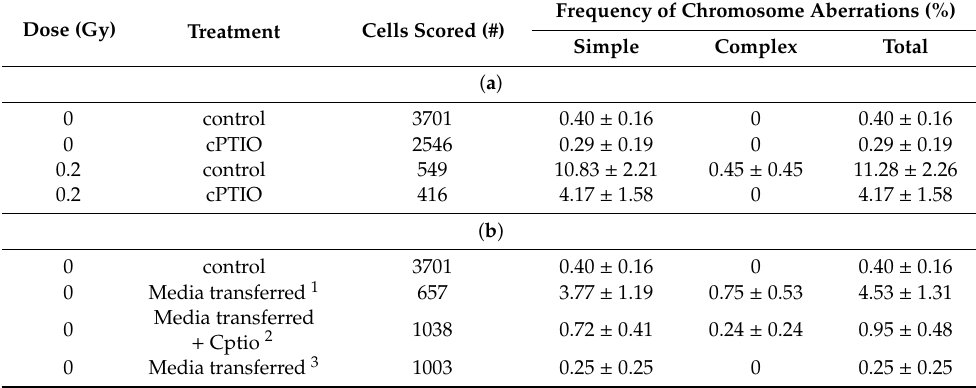
1 Media from 0.2 Gy Fe-ion irradiated cell culture were taken 1 hr after irradiation, filtered and transferred to non-irradiated cells. 2 Media from 0.2 Gy Fe-ion irradiated cell culture were taken 1 hr after irradiation, filtered, cPTIO was added, followed by transfer to non-irradiated cells. 3 Media without cells were irradiated with 0.2 Gy Fe-ions and transferred to non-irradiated